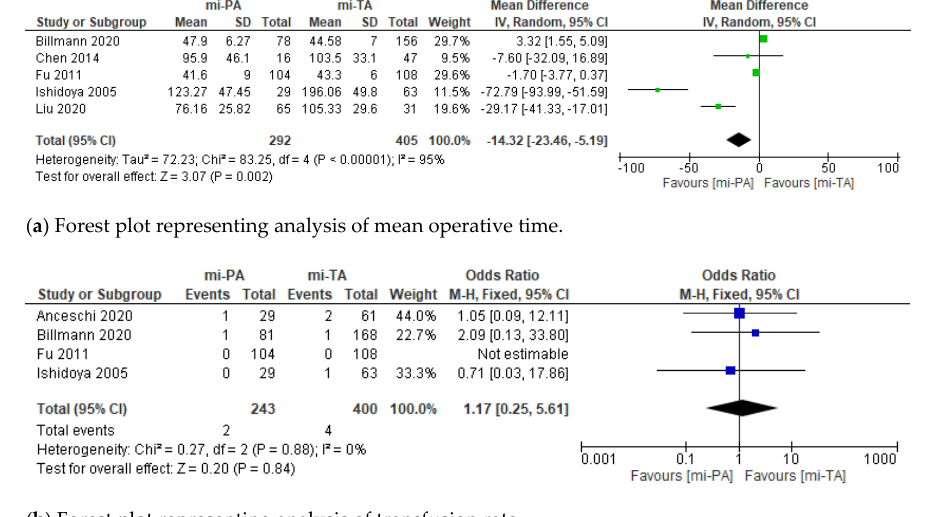
( b ) Forest plot representing analysis of transfusion rate.